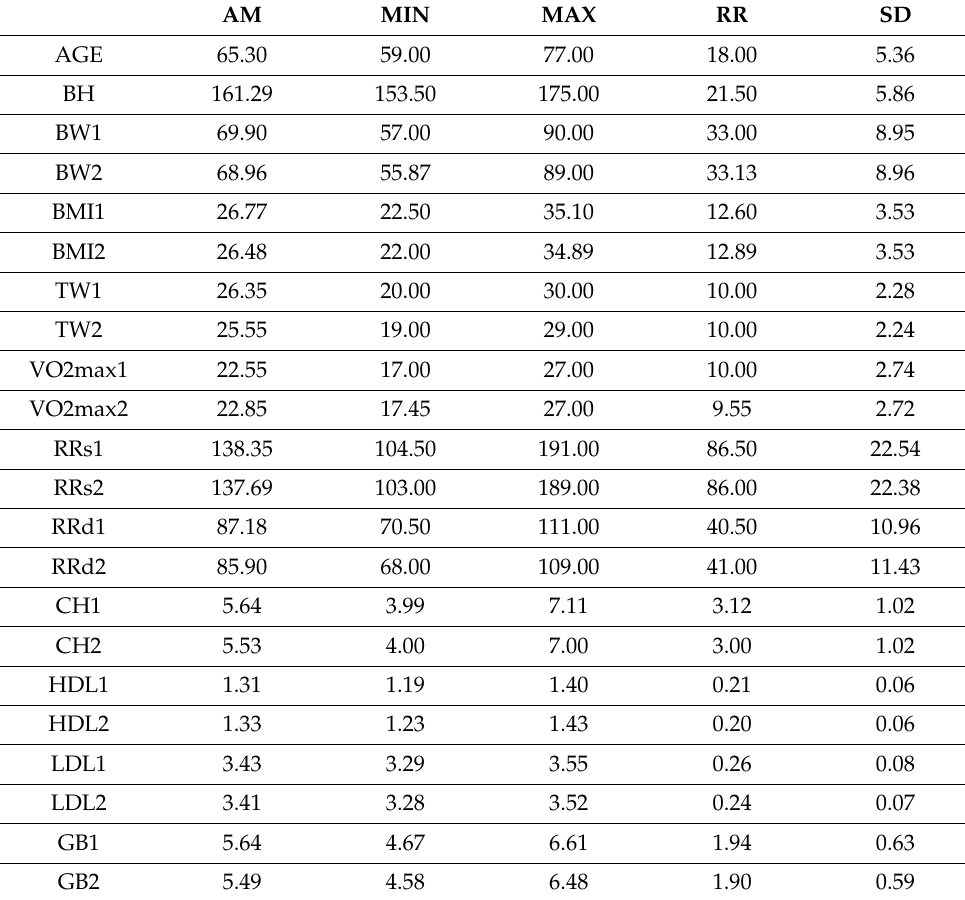
Table 2. Descriptive parameters of the second experimental group (initial and